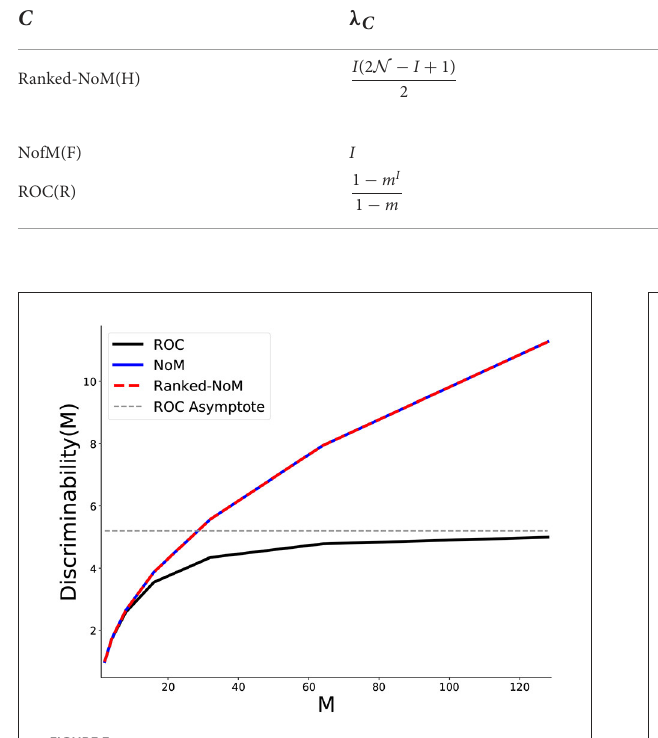
FIGURE4 Comparison of discriminability for the three coding schemes during propagation. The Discriminability, D C ( I ) (Equation 2.7) is reported as the number of inputs I builds up, for each coding scheme: ROC (black), NoM (blue), and Ranked-NoM (red). For ROC coding, the inputs I accumulate up to the maximal number (here, M 31) while, in the two others, propagation stops = beyond N 15 (in this case, we retain the value D C ( N ) for later =